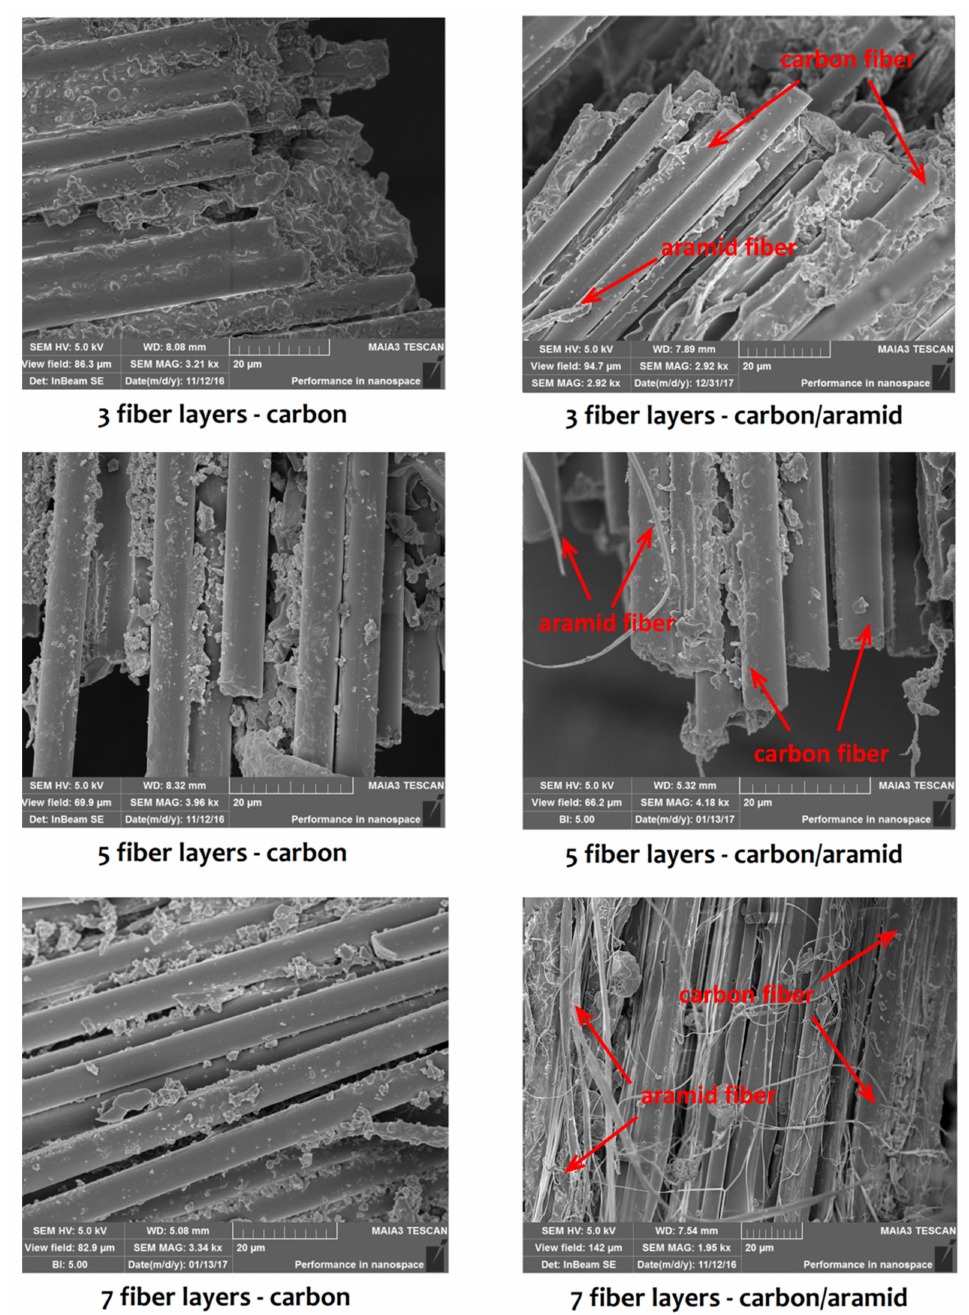
Figure 5. Scanning electronic microscope (SEM) micrographs of di ff erent patch fracture